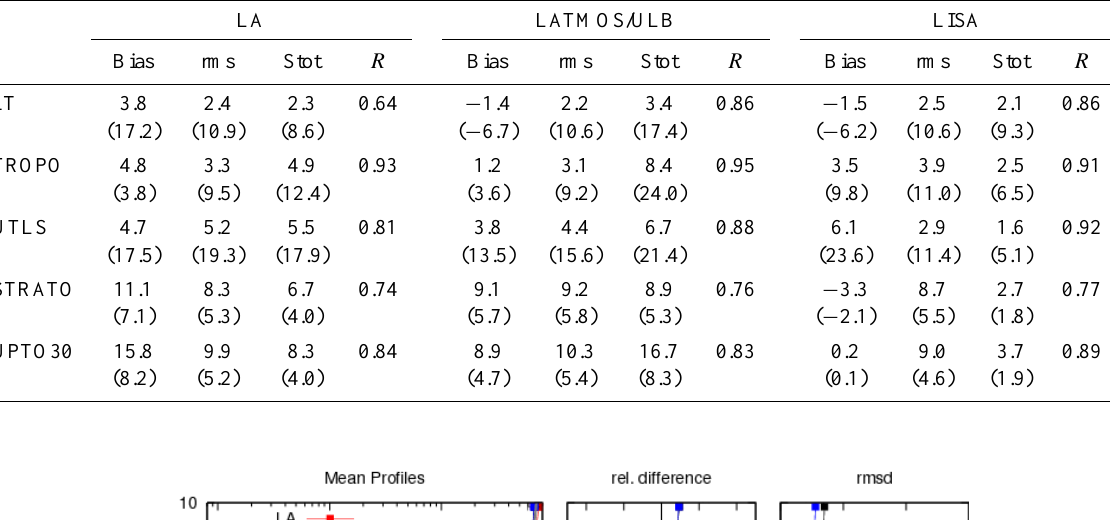
Table 7. Same as Table 6 but for the tropics.